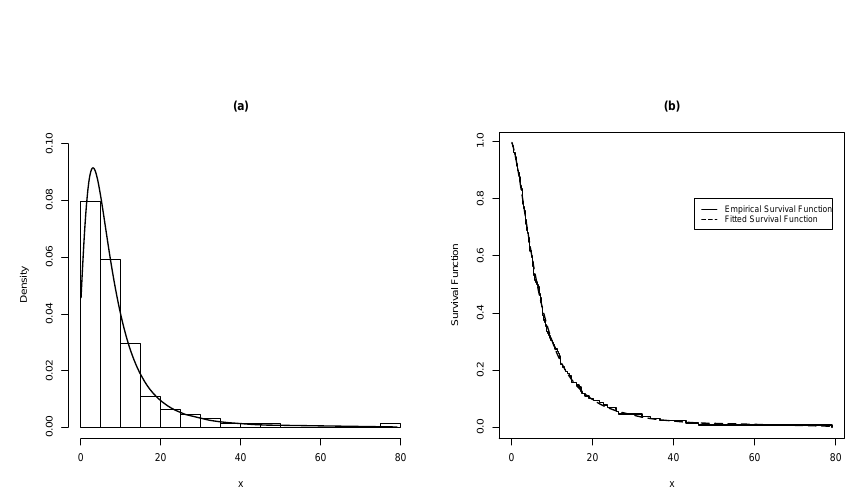
Figure 2 – Graphs of the fitted APTL density and survival functions for data set 1.